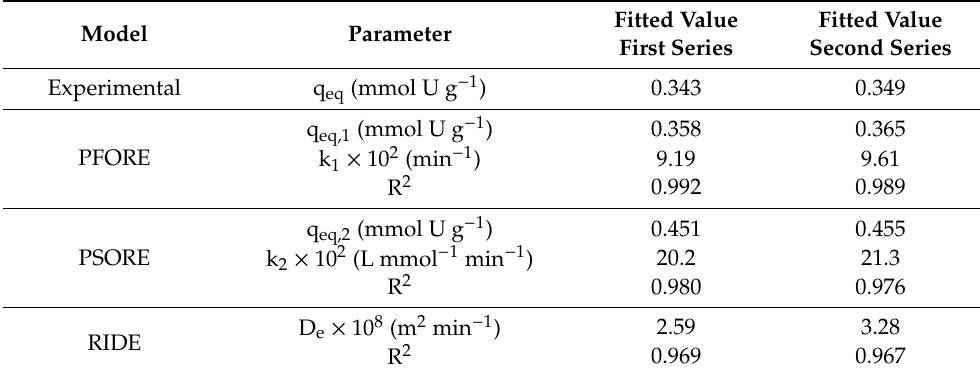
Table 1. Parameters of models for U(VI) uptake